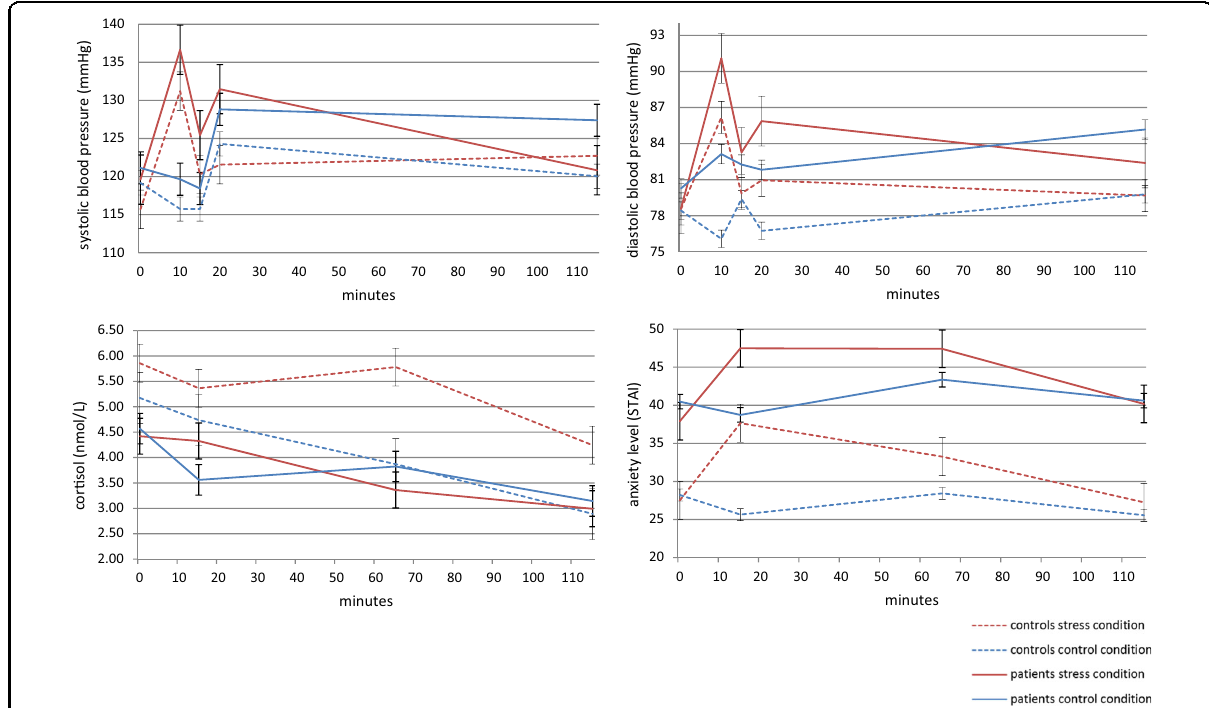
Fig. 2 Physiological and subjective stress response, time points: baseline (0 min), after water test (10 min), after math task (15 min), before scanning session (20 min), before resting-state scan (65 min) and after scanning (115 min) reported as the mean with standard